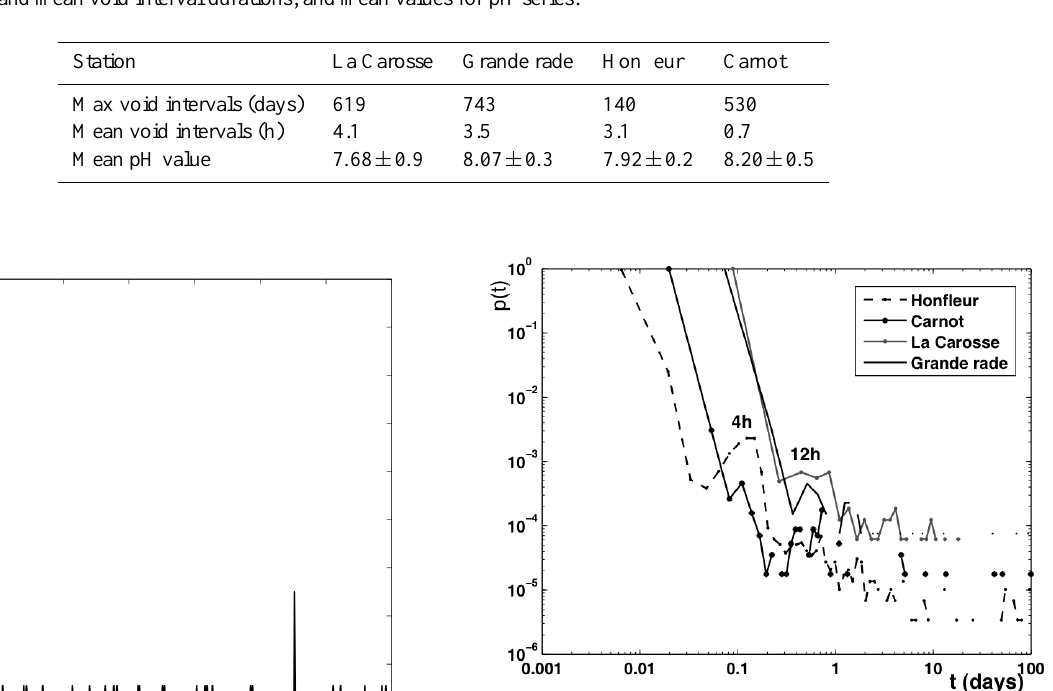
Table 2. Maximum and mean void interval durations, and mean values for pH series.